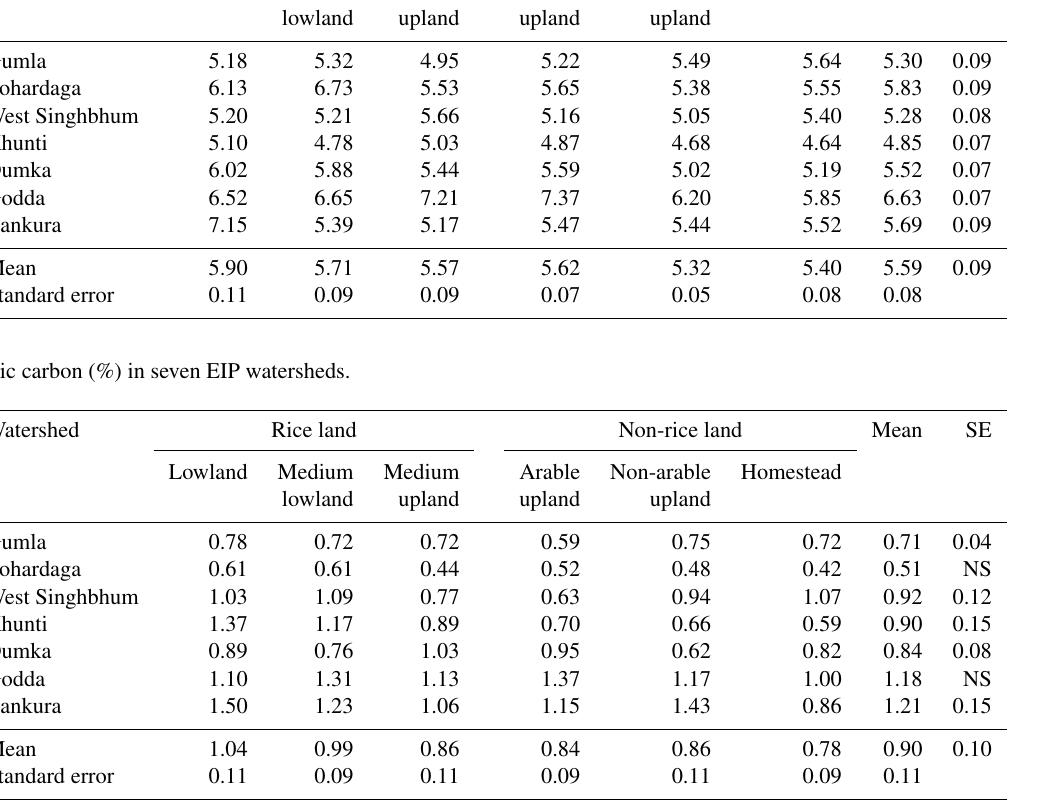
Table 1. Soil pH w in seven EIP watersheds. Values are the mean of six fields, and SE is the standard error. Watershed